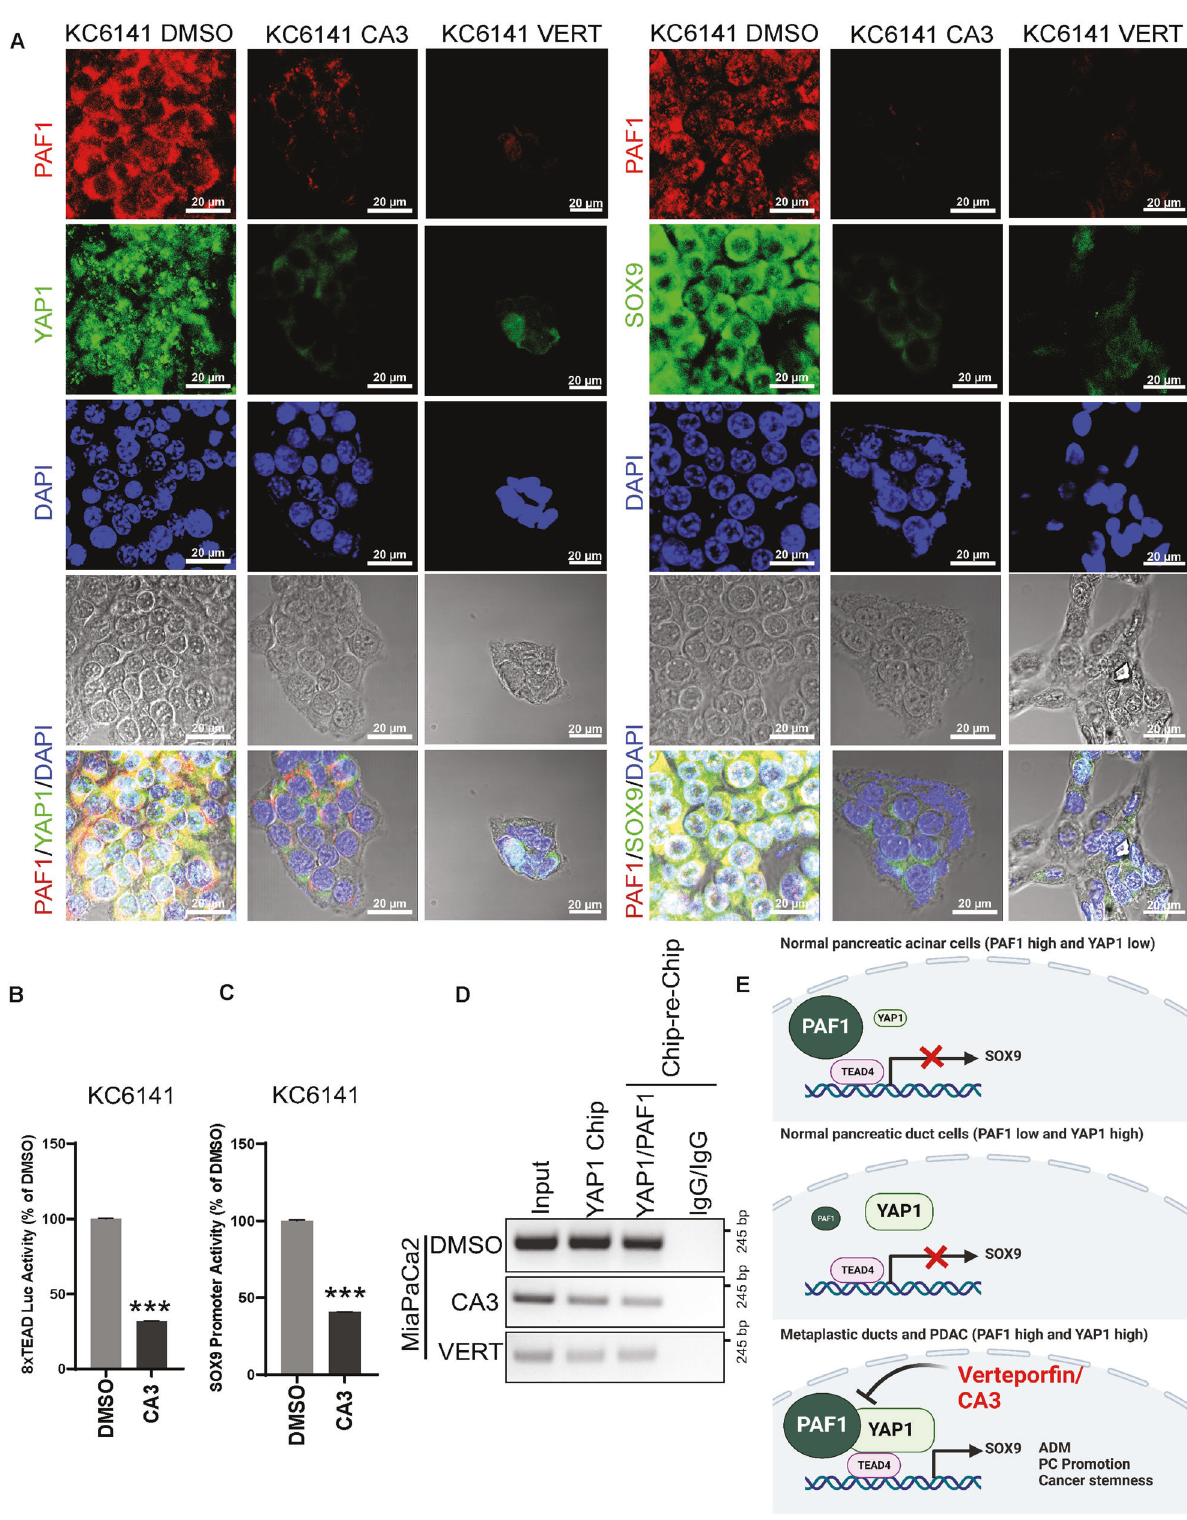
Fig. 7 CA3 and vertepor fi n inhibit the PAF1/YAP1/TEAD4-mediated transcriptional activation of SOX9 in PC development. A Confocal images of immuno fl uorescence staining for PAF1 co-expression with YAP1 and SOX9 in the presence and absence of CA3 (1 µM, 48 h) or vertepor fi n (2 µM, 48 h) treatment in KC6141 cells. B , C 8xTEAD luciferase and SOX9 promoter activity luciferase assays KC cells treated with CA3 or vehicle control. The bar graphs show activities of 8xTEAD synthetic and SOX9 promoters represented as the percentage of control (DMSO). Data are mean ± SD, n = 3. Signi fi cance was determined with a student ’ s t test. * p < 0.05, ** p < 0.01, *** p < 0.001, ns: non-signi fi cant, p > 0.05. D ChIP-re-ChIP assay was performed in MiaPaCa2 cells treated with DMSO or CA3 (1 µM, 48 h) or vertepor fi n (2 µM, 48 h) using PAF1, YAP1, and control IgG antibodies using primers that amplify SOX9 promoter. Immunoprecipitated and puri fi ed DNA was ampli fi ed using PCR followed by agarose gel electrophoresis. E Schematic shows the overall summary of the study. Cell Death and Disease (2022)